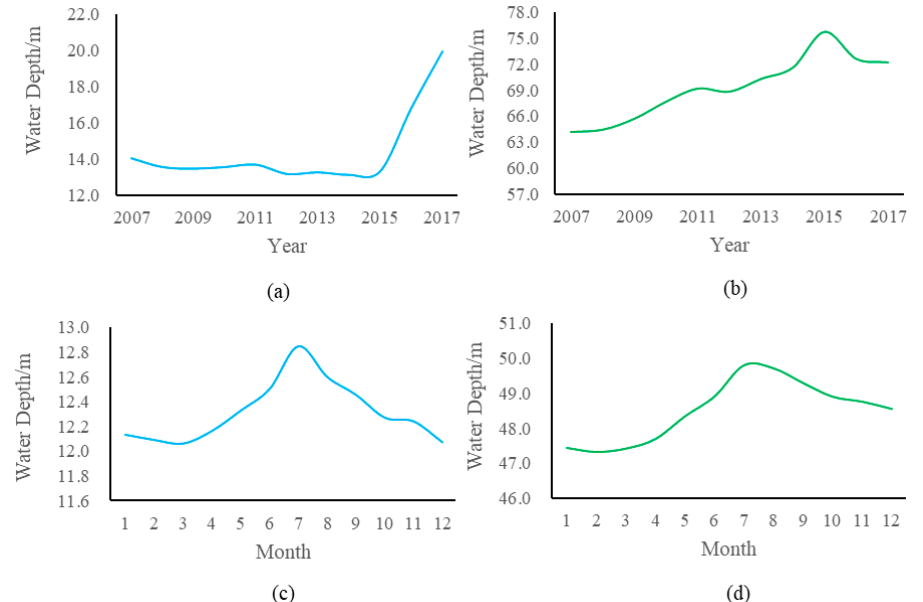
Figure 7. The interannual and monthly water depth trend of an unconfined and confined aquifer. Interannual water depth trend of an unconfined aquifer ( a ), Interannual water depth trend of a confined aquifer ( b ), Monthly water depth trend of an unconfined aquifer ( c ), Monthly water depth trend of a confined aquifer ( d ).